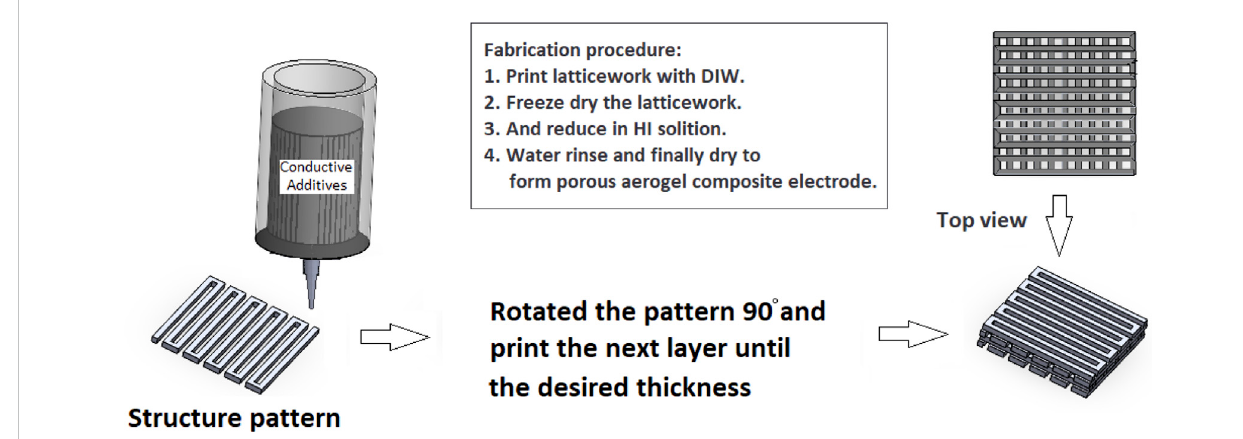
FIGURE 4 Diagram of the printing process. Based on data from Li et al.